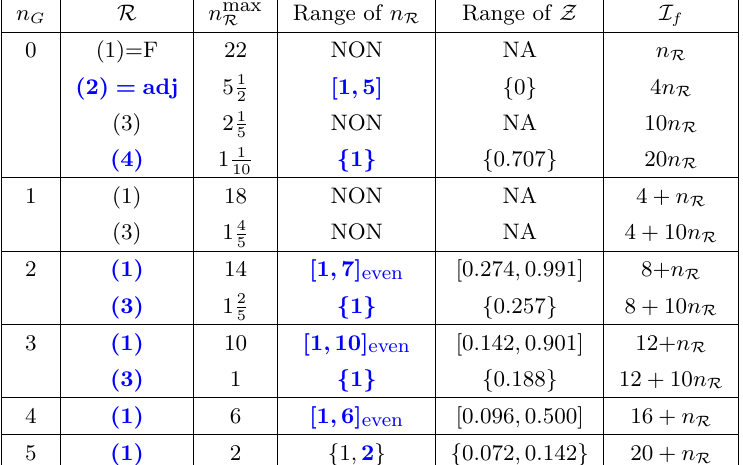
1 2 f 1 g f 0 : 257 g 8 + 10 n R 5 (1) 10 [1 ; 10] even [0 : 142 ; 0 : 901] 12+ n R